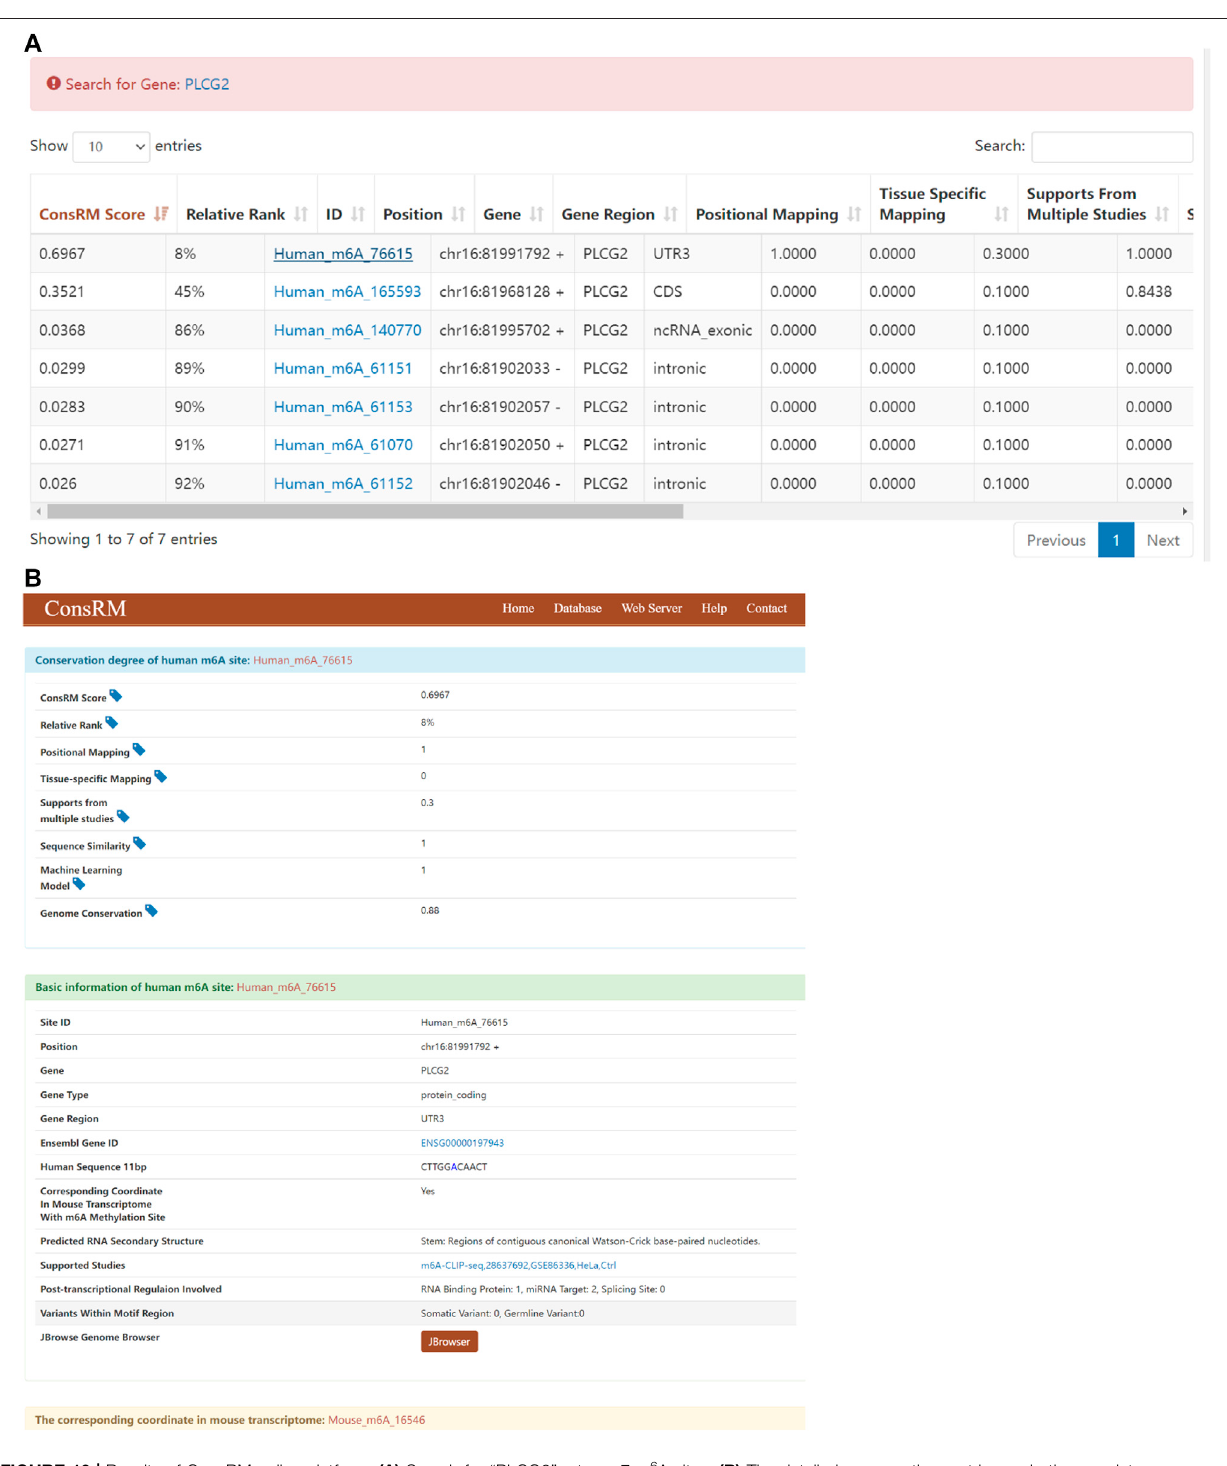
Frontiers in Genetics |